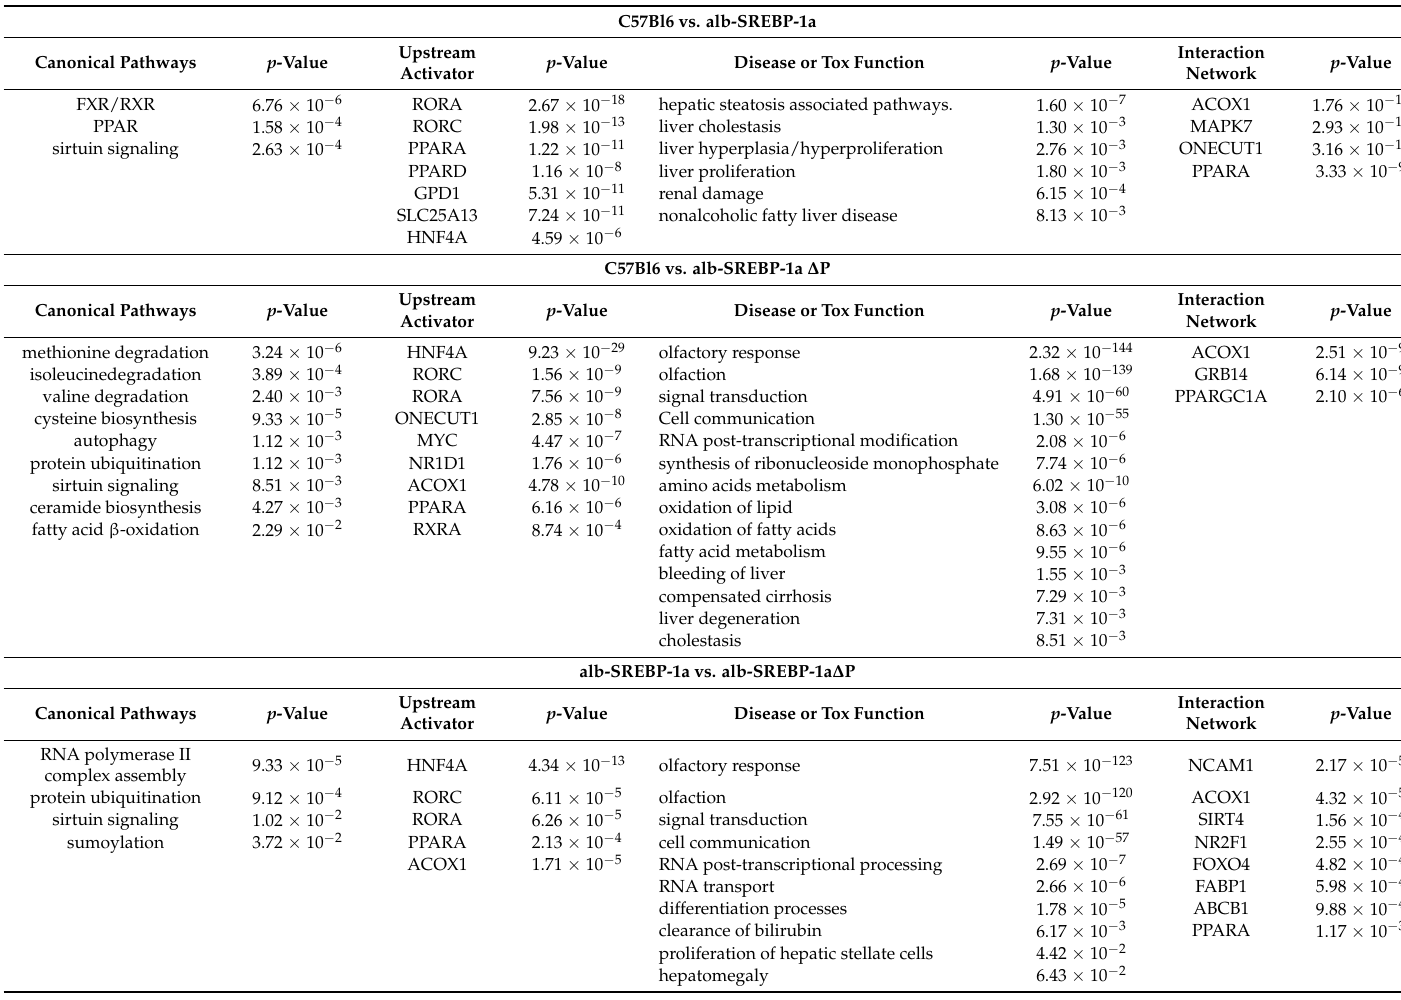
Table 2. Differential expression Core analyses of regulated transcripts in the comparisons C57Bl6 vs. alb-SREBP-1a , C57Bl6 vs. alb-SREBP-1a ∆ P and alb-SREBP-1a vs. alb-SREBP-1a ∆ P . Examples as listed in text. p -value: p -value for enrichment of pathway molecules in the data set. Complete analyses are given in Tables